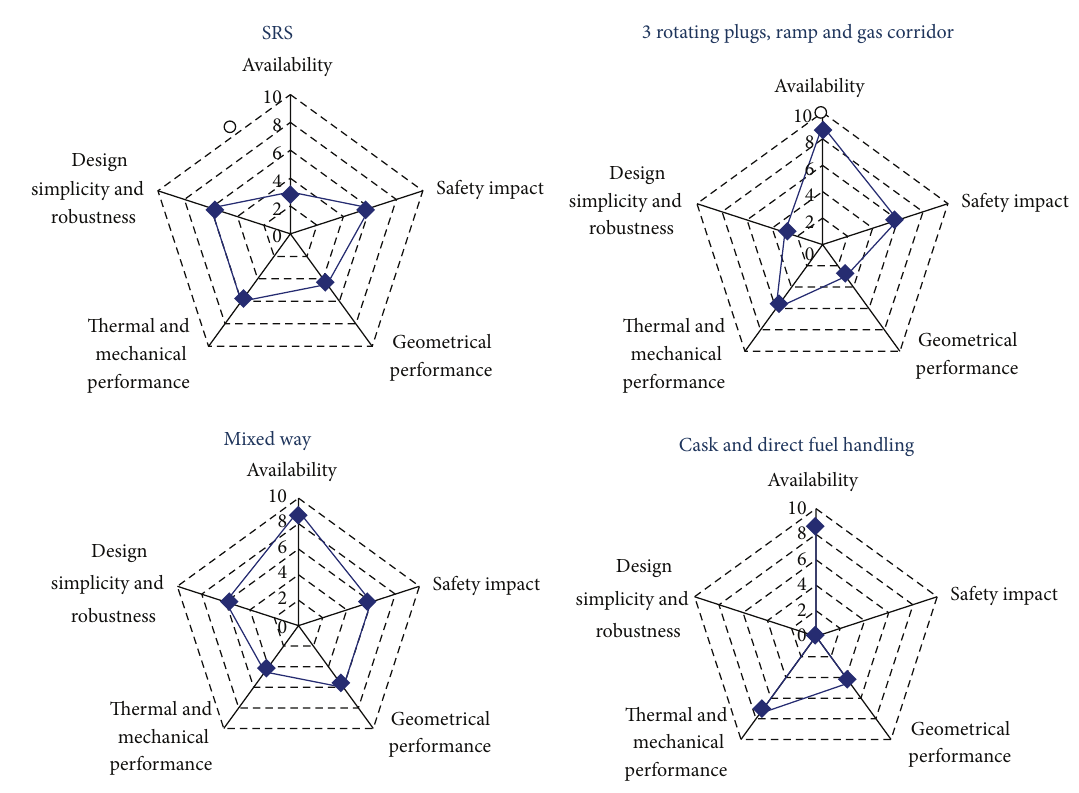
Figure 20: Performance of the options (“radar” diagram).